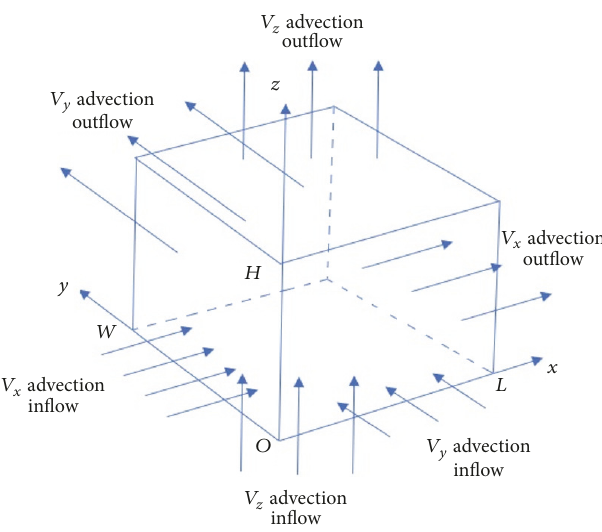
Figure 1: Domain of